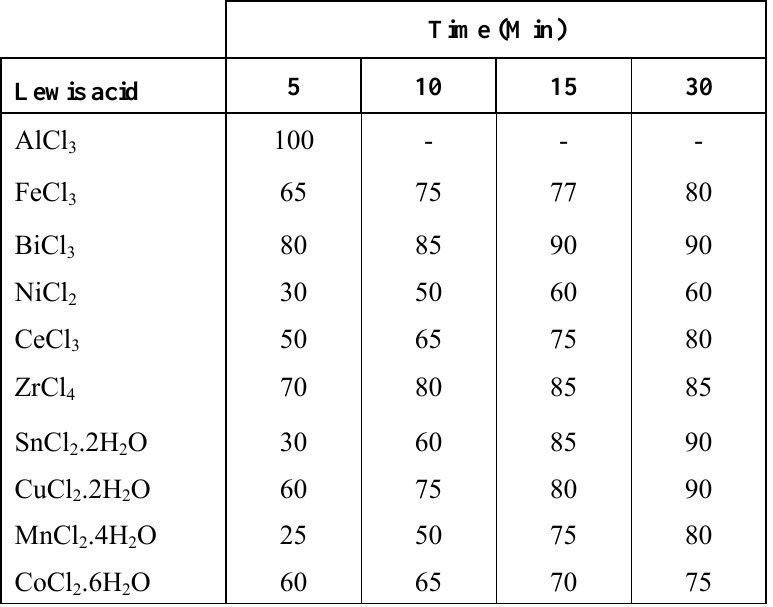
Table 1. Percent Conversion of Benzhydrol to Benzophenone with K